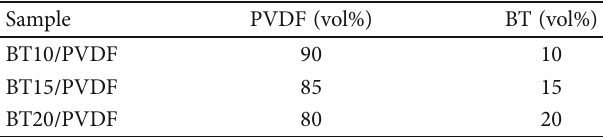
Table 1: Compositions of BT/PVDF